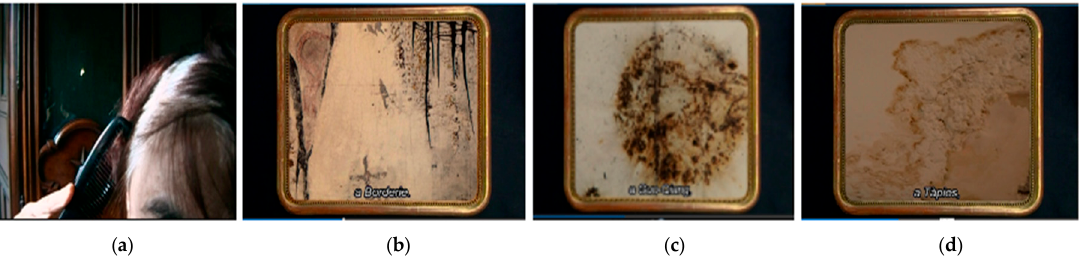
Figure 9. Selection of the detail of Van der Weyden’s The Last Judgement on which Varda’s camera lingers for a full minute accompanied by the music of Bruzdowicz.